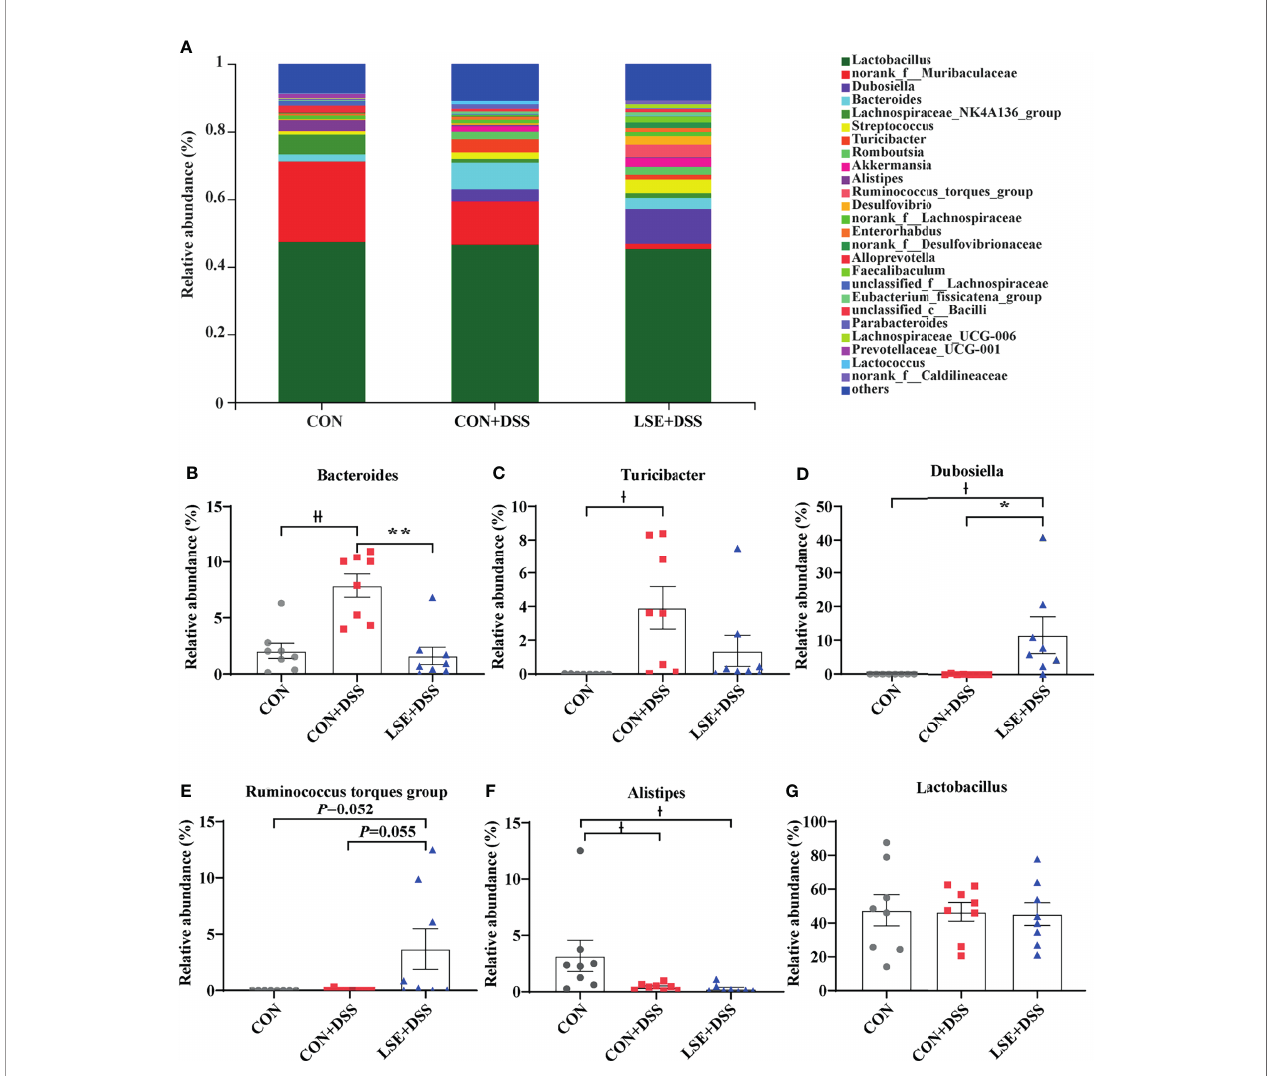
FIGURE 6 | Effects of LSE administration on intestinal microbiota in fl ammatory in DSS-induced colitis mice. (A) Structural comparison of intestinal microbiota between LSE+DSS, CON+DSS, and CON groups at genus levels. (B) Relative abundance of Bacteroides . (C) Relative abundance of Turicibacter . (D) Relative abundance of Dubosiella . (E) Relative abundance of Ruminococcus torques group. (F) Relative abundance of Alistipes . (G) Relative abundance of Lactobacillus . Data are presented as mean ± SEM, n = 8. * P < 0.05 and ** P < 0.01 vs. the CON+DSS group, † P < 0.05 and †† P < 0.01 vs. the CON